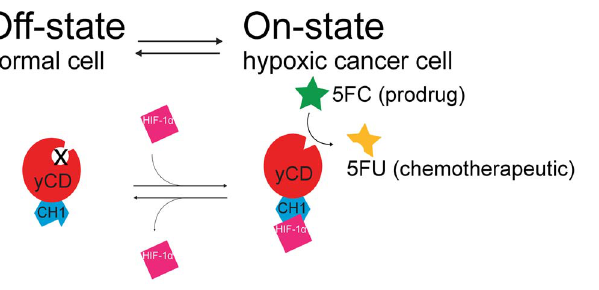
Figure 1. Schematic depiction of HIF-1 a -Activated Protein Switches (Haps). These protein switches are composed of the prodrug-converting enzyme yeast cytosine deaminase (yCD), which converts the non-toxic prodrug 5-fluorocytosine (5FC) to the highly toxic chemotherapeutic 5-fluorouracil (5FU), and the HIF-1 a - binding CH1 domain of the human p300 protein. The cancer marker, HIF-1 a , modulates the enzymatic activity of the yCD-domain of the switch, either through an allosteric mechanism or through stabilizing the protein such that it accumulates at higher levels in the cell. In normal cells HIF-1 a is absent and the yCD domain is inactive. In the presence of HIF-1 a – ideally only in cancer cells – the yCD domain is active and able to produce the